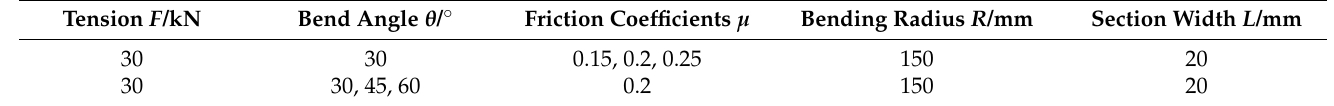
Table 1. Stretch-bend